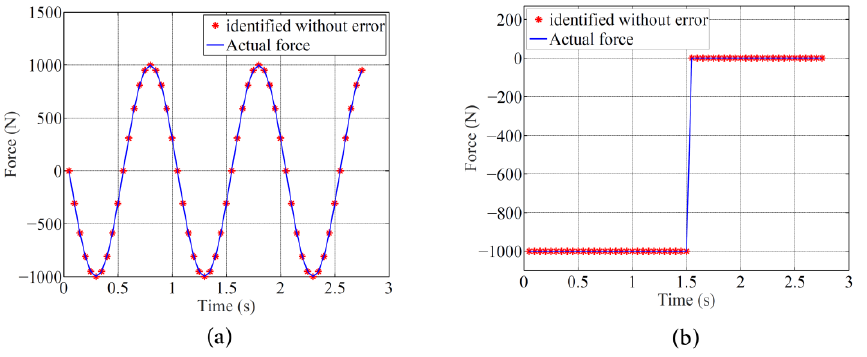
Figure 6. The identified time variation in the ( a ) sinusoidal, and ( b ) step load with no measurement error.